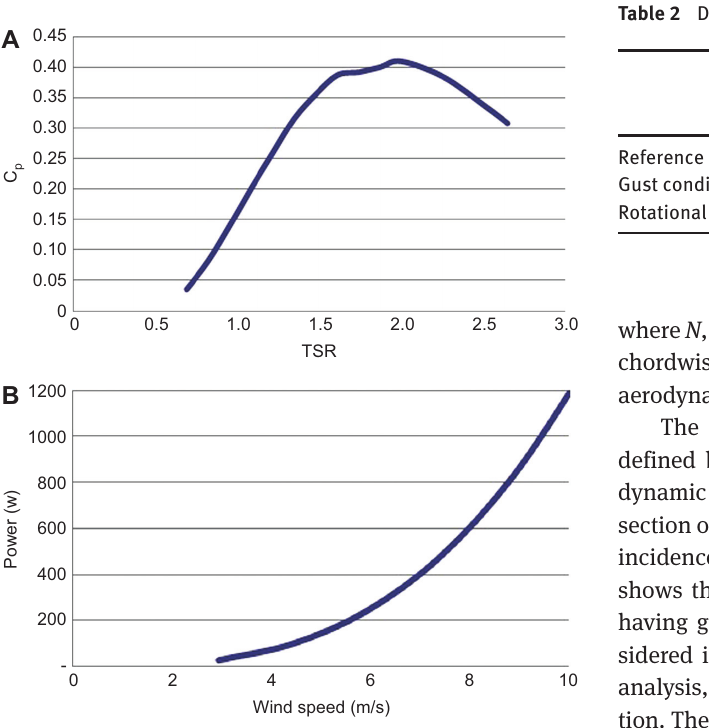
Figure 6 Performance calculation results of the designed wind turbine.